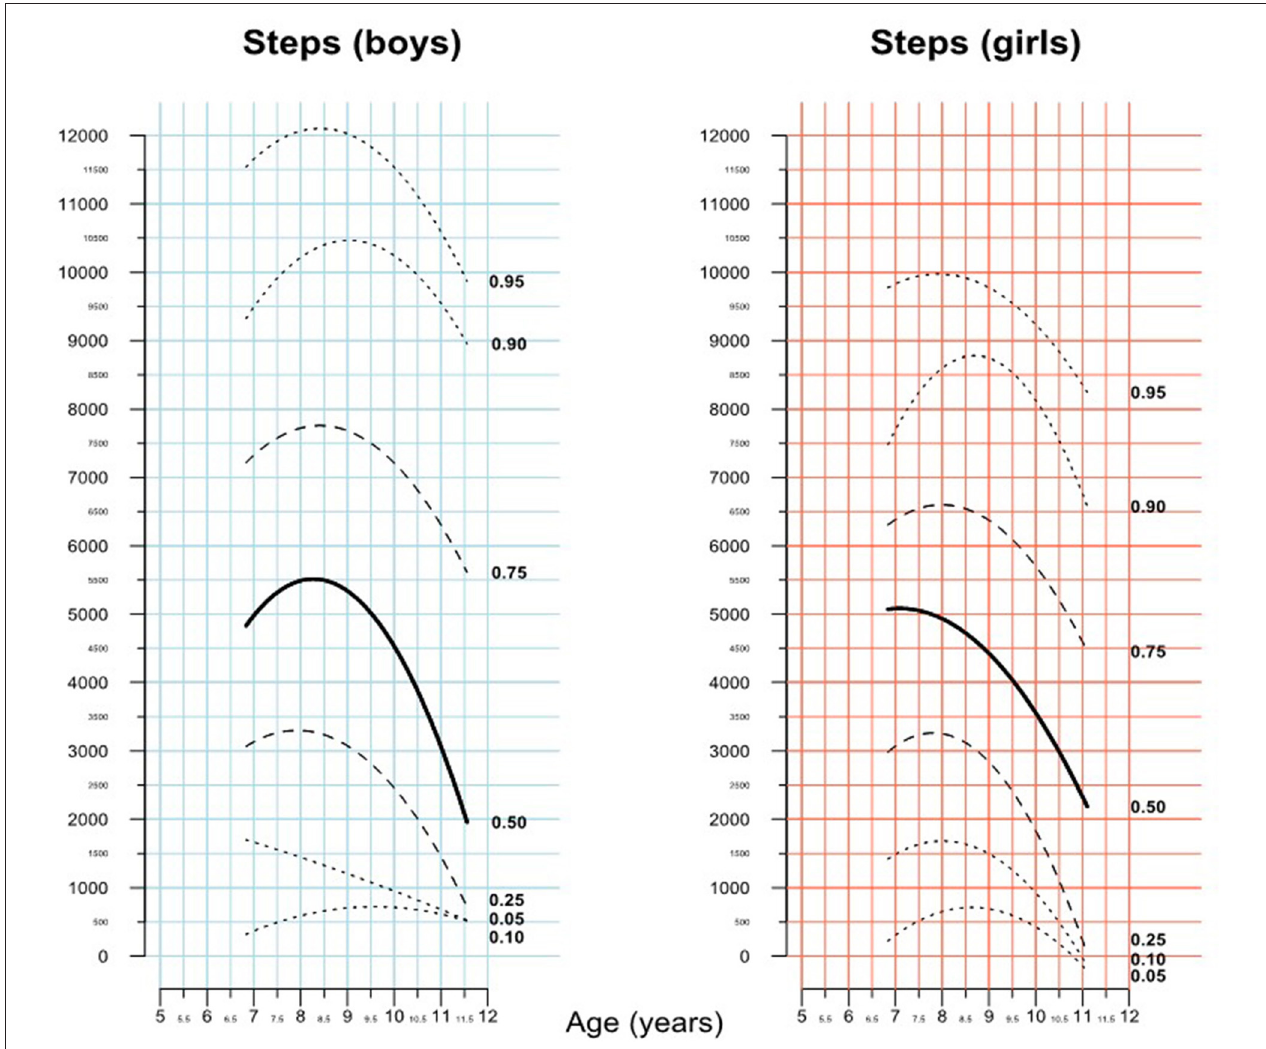
FIGURE 5 | Percentiles of cumulative step counts during the time period 1–6 p.m. by gender and age